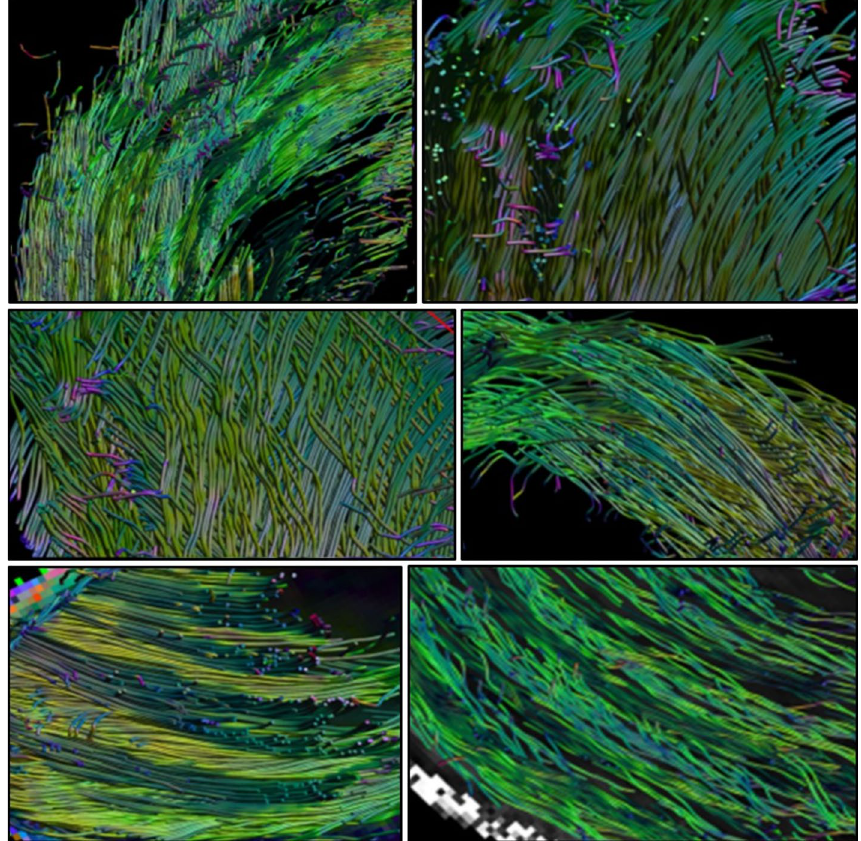
Figure 3. Images taken from the 3D rotating reconstruction of the fiber tracts that compose the AF in six different samples. The characteristic structure of the AF is present in all the samples scanned with local variations appearing in each